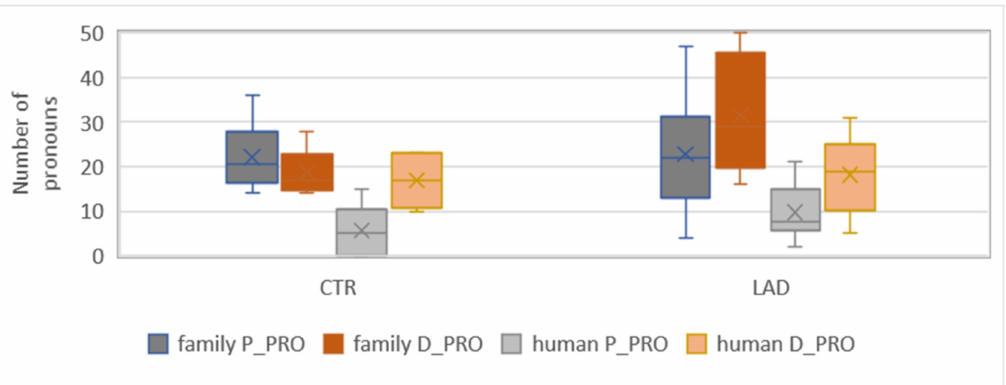
Figure 5. Range of proportions of D-pronoun (D_PRO) and personal pronoun (P_PRO) in references to family members and (other) humans in the CTR group and the LAD group.